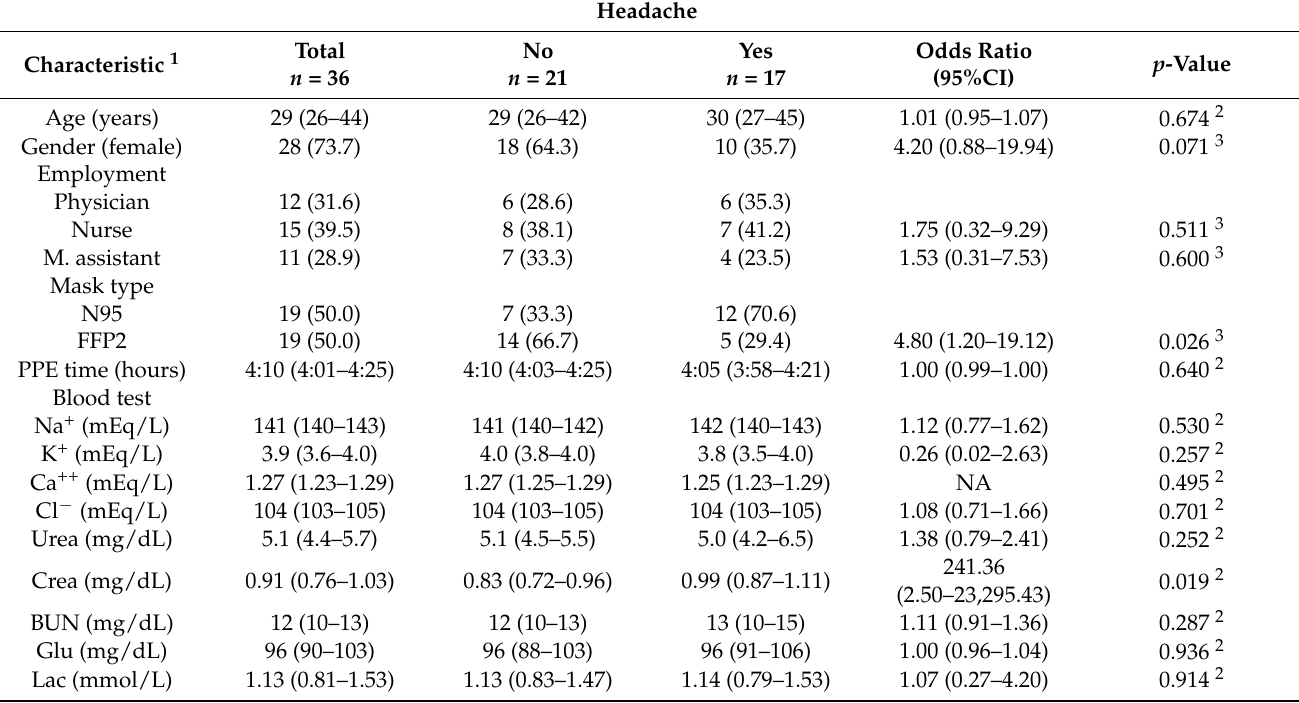
Table 2. Characteristics of the study population.